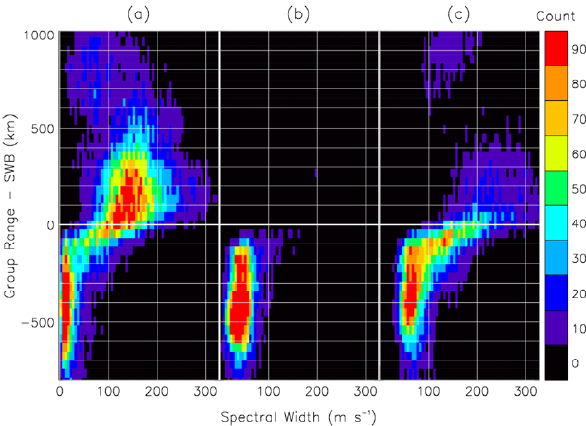
Fig. 3. A set of histograms showing the number of echoes found within 5ms − 1 bins of spectral width on beam 4 during the interval, 12:15 to 15:00UT on 10 December 1999. The results have been sorted according to spectral fit type: Lorentzian fit (red), indetermi- nate fit (yellow), and Gaussian fit (blue); and into categories above (bold) and below (thin) the SWB.